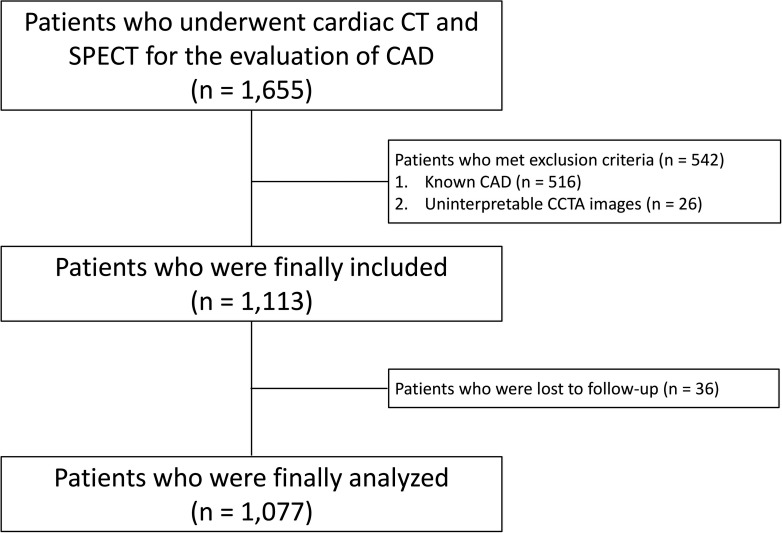
CONSORT diagram of the study population selection.CCTA, coronary computed tomographic angiography; SPECT, single-photon emission computed tomography; CAD, coronary artery disease.